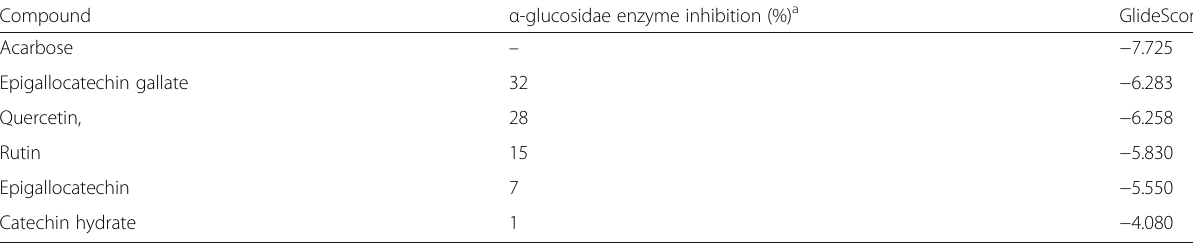
The Glide-Scores of compounds: acarbose, epigallocatechin gallate, quercetin, rutin, epigallocatechin and catechin hydrate were found to go in parallel with their experimental α -glucosidase inhibitory activities. All compounds showed weaker inhibitory activity on α -glucosidase except for epigallocatechin gallate. The more negative Glide Score values represent tighter binders a